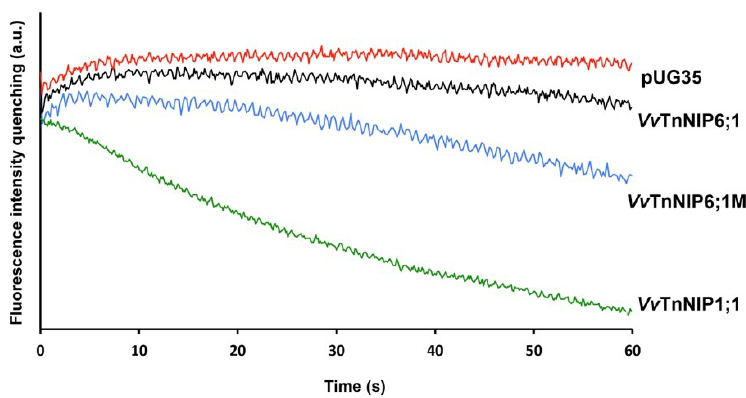
Figure 3. Traces obtained from stopped-flow spectroscopy. The hyperosmotic shock (with 2.1 M glycerol) was applied to the yeast cells (equilibrated with 1.4 M sorbitol) expressing functional NIPs ( Vv TnNIP1;1, Vv TnNIP6;1) of grapevine and empty plasmid pUG35. C-terminal extension in Vv TnNIP6;1M homolog showed higher glycerol influx rate, whereas, Vv TnNIP1;1 strain exhibited highest glycerol influx.